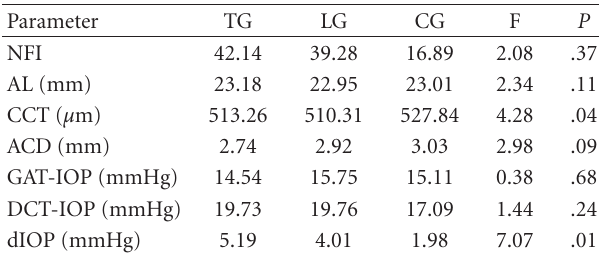
Table 1: Mean NFI, AL, CCT, ACD, GAT-IOP, DCT-IOP, and dIOP scores in TG, LG, and CG as well as ANOVA F values and respective levels of statistical